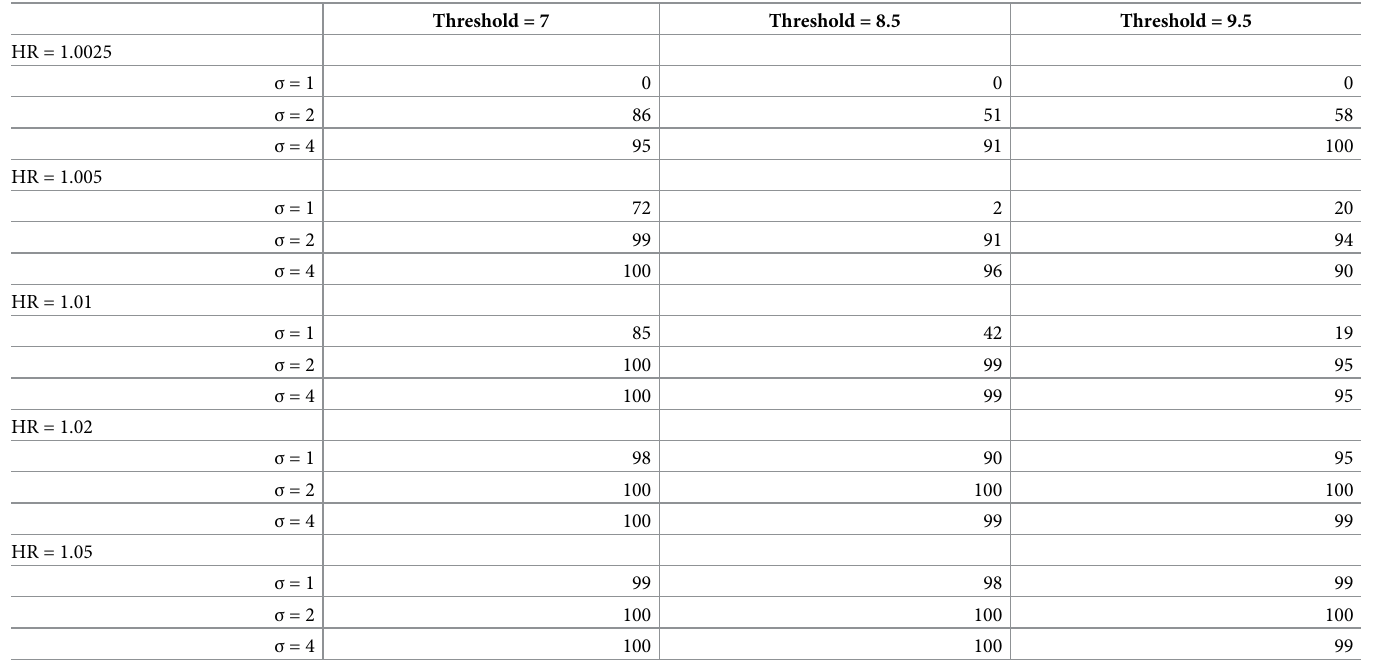
Table 5. True hazard ratio above upper limit of estimated hazard ratio, under varying amounts of measurement error and different “true” C-R